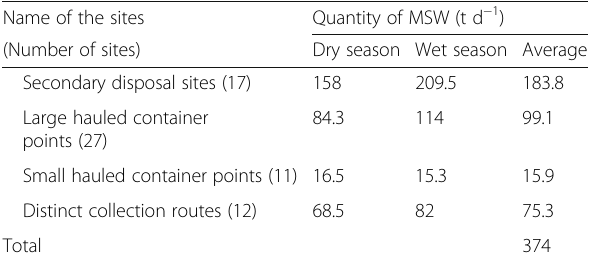
Table 1 Details of input data for baseline scenario in IWM model